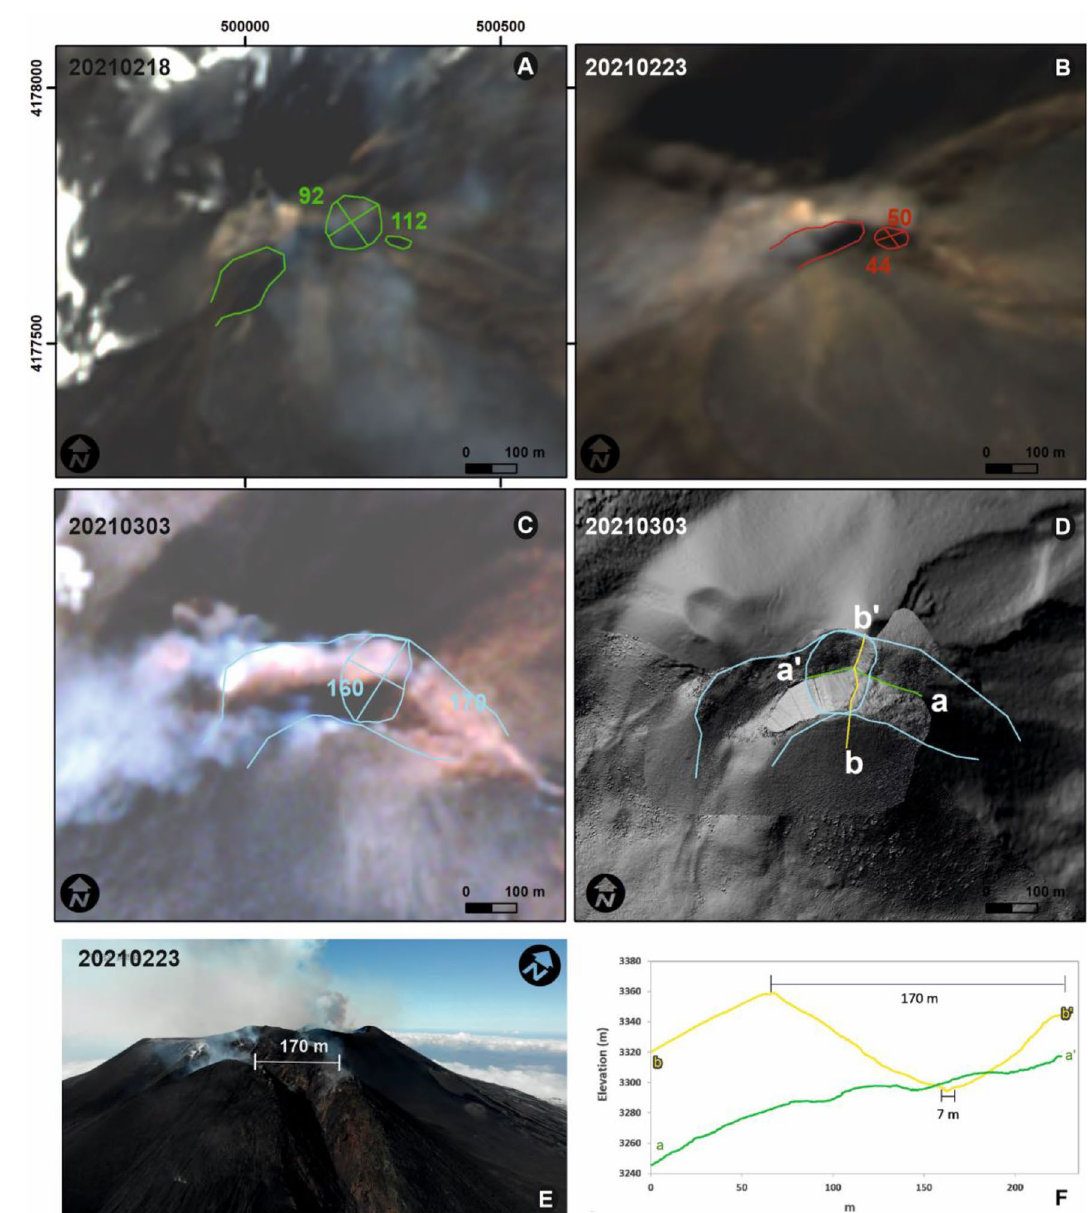
Figure 6. Satellite images (Sentinel-2 L1C) and topography of the SEC. ( a – c ) Sentinel-2 L1C images were taken on ( a ) 18 February, ( b ) 23 February and ( c ) 3 March 2021. ( d ) Shaded relief map is obtained from UAS survey on 3 March. The blue colored lines show the crater rim and the breaching on the SEC upper flanks. ( e ) Oblique view image was taken by UAS on 3 March showing the SEC eastern rim and the eastern breach. ( f ) Cross sections show transects in E-W and S–N directions corresponding to green and yellow lines in panel ( d ). Coordinate system UTM WGS 84 33 N. Satellite images were downloaded from https:// www. senti nel- hub. com/ explo re/ eobro wser/ with gain, gamma, brightness and contrast adjusted to emphasize the morphological aspects. Afterward, crater rims have been drawn and measured by ArcMap 10.3 https:// www. esri. com/ en- us/ home. Oblique view image shown in (e) was taken by UAS by co-author Massimo Cantarero, the UAS pilot, and the conduit was drawn with CorelDraw X5 https:// www. corel draw.